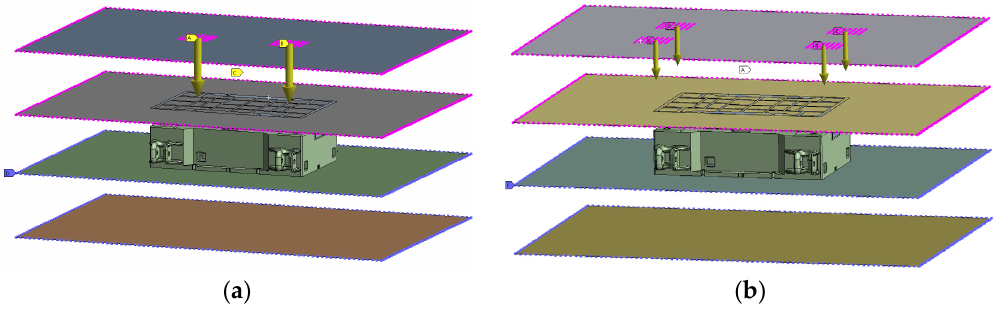
Figure 4. Principal representation of the boundary conditions used in the simulation to create virtual pressure distribution for a ( a ) 2-point press and a ( b ) 4-point press.